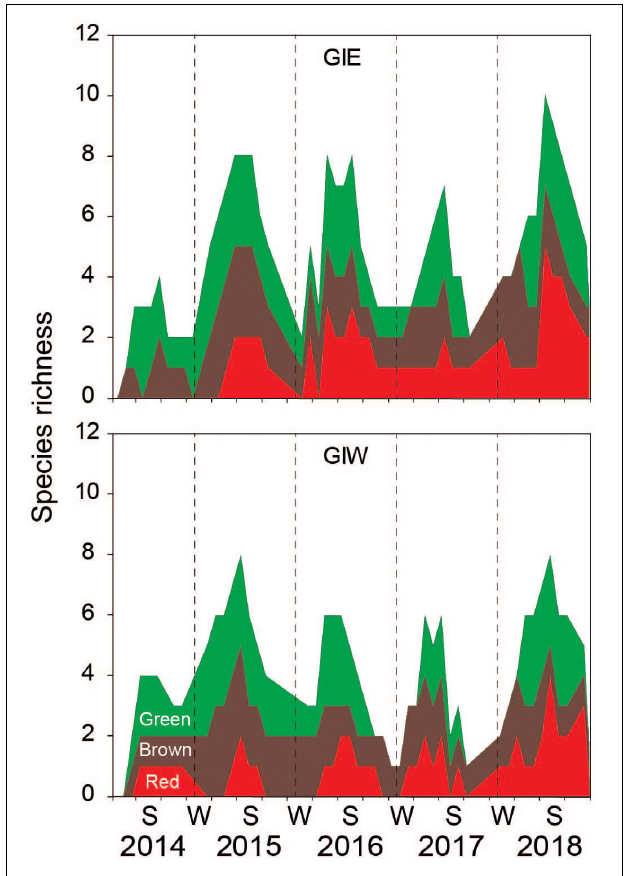
FIGURE 3 | Species richness of macroalgae at station GIE and GIW in Gyldensteen Coastal Lagoon from April 2014 to December 2018. The data are given as cumulated red + brown + green macroalgal species at each date as indicated by the corresponding color